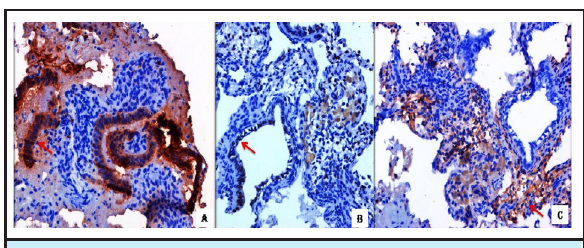
Figure 3. (A): Cytokeratin 7: Cytoplasmic staining for CK7 was present in the glandular component DABx100) (B): Estrogen receptor: Nuclear staining for ER was present in the glandular component (DAB x100) (C): CD10: Positive staining for CD 10 was present in the stromal component. (DAB x100) Based on all the findings a diagnosis of scar site endometriosis was rendered.